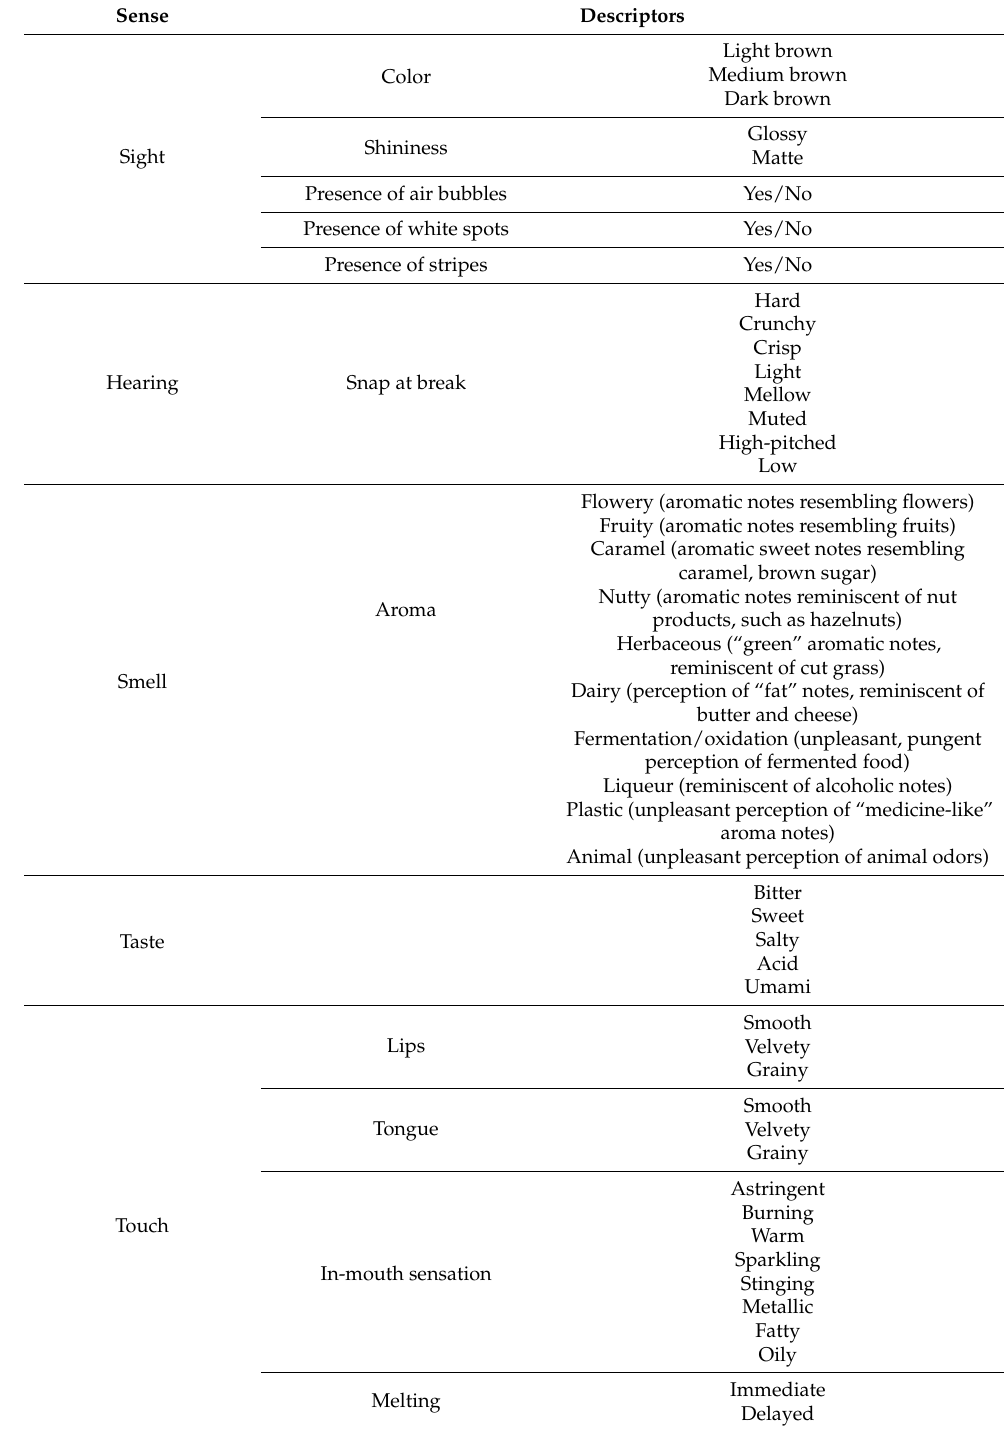
Table 1. Sensory evaluation guidelines for the panel test tasting session. For each sample, the panelists had to check all that they felt applied (yes/no selection for each